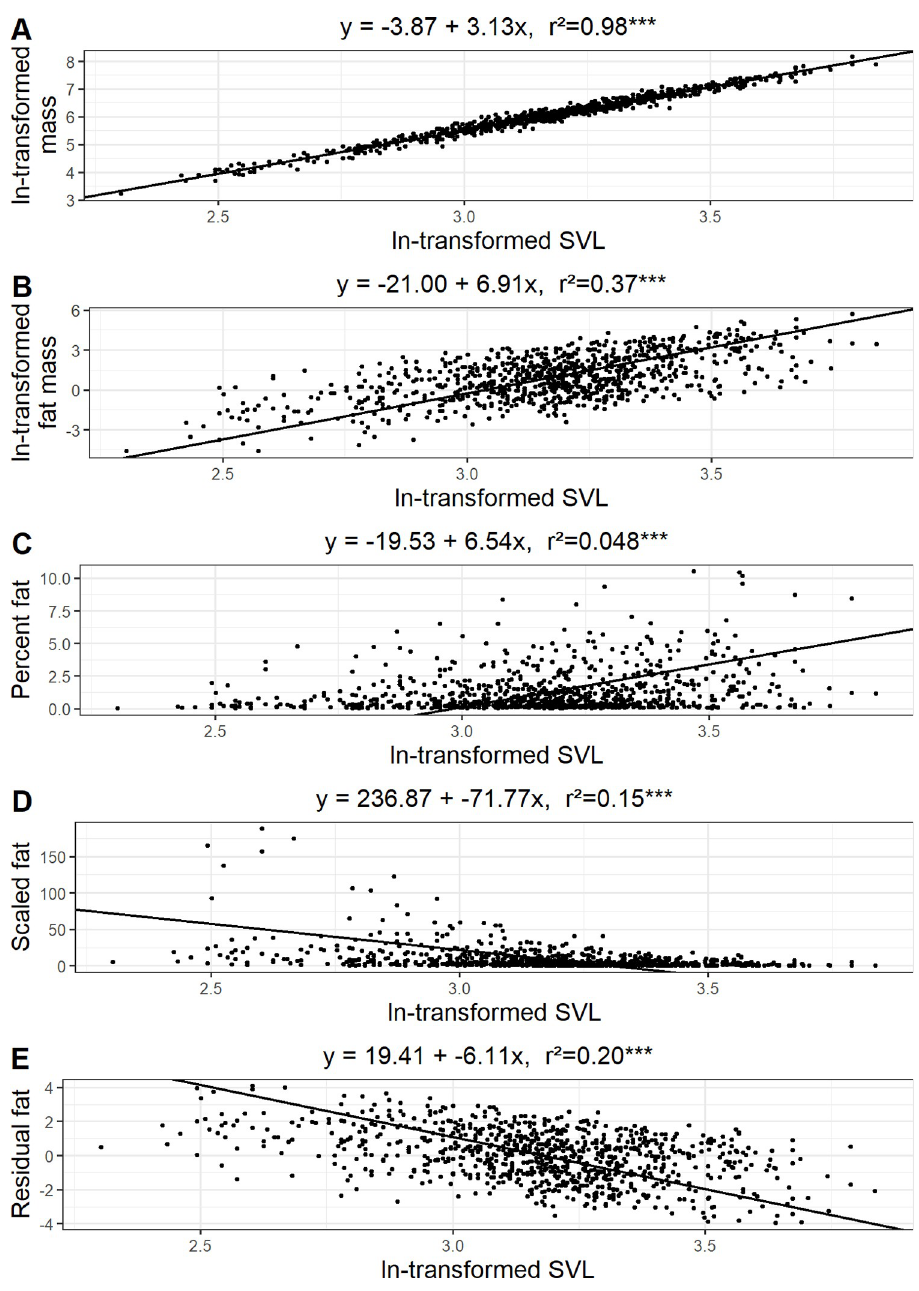
Fig 1. Relationships between ln-transformed snout-vent length (SVL). and A) ln-transformed body mass, B) ln- transformed wet-fat mass, C) percent fat, D) scaled fat, and E) residual fat. SMA regression equations intercepts, slopes, and adjusted r 2 values are reported to two significant digits. Significance values are reported as � P � 0.05, �� P � 0.01, and ��� P � 0.001. between males and females (p-value = 0.57). However, the allometric relationship between ln- transformed wet-fat mass and ln-transformed SVL differed significantly between males and females (p-value = 0.02) with a greater predicted slope value for females (7.38) than males (6.55) but overlapping confidence intervals (females 6.85–7.95, males 6.55–7.04). Due to the